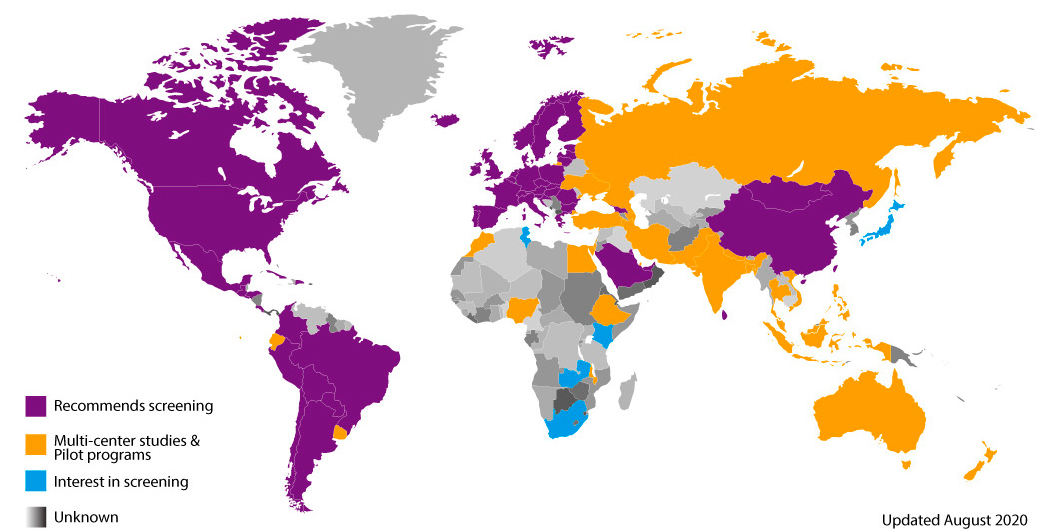
Figure 1. Critical congenital heart disease screening global implementation map.